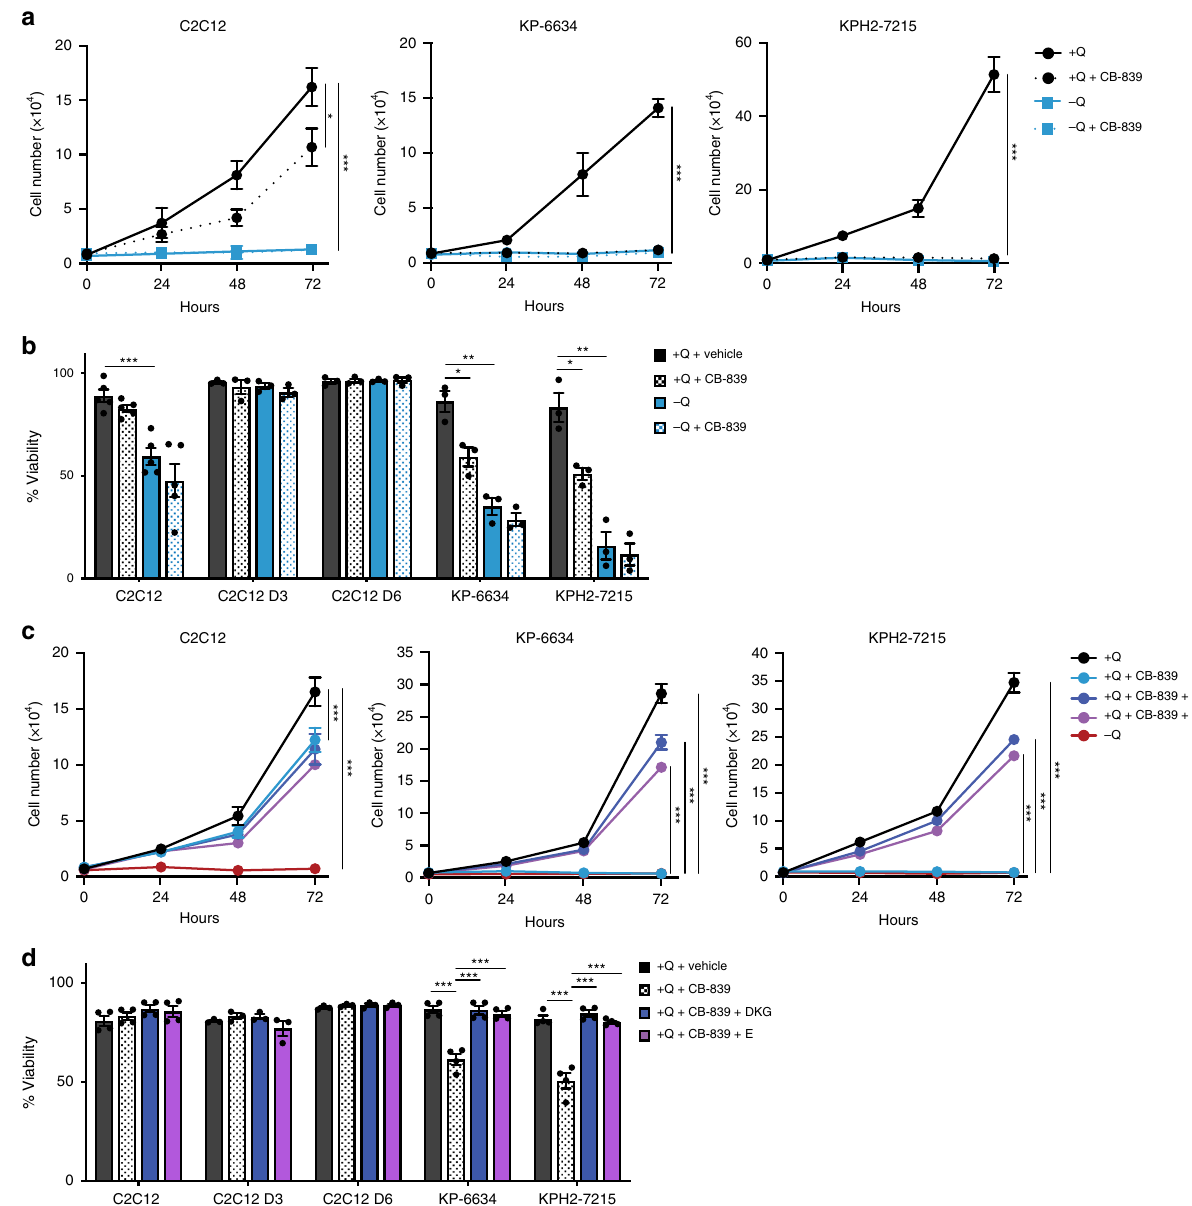
Fig. 5 Glutaminase inhibition with CB-839 and effects on UPS cells. a Proliferation of C2C12s, KP-6634s, and KPH2-7215s (left to right) grown in media with or without glutamine (Q) and treated with 1 μ M CB-839. N = 3 with three technical replicates. Data represent mean ± s.e.m.; * p < 0.05, *** p < 0.0005. b Viability of C2C12, C2C12 D3, C2C12 D6, KP-6634, and KPH2-7215 cells grown in media with or without Q, treated with 1 μ M CB-839 and assessed after 48 h. N = 3 with two technical replicates. Data represent mean ± s.e.m.; * p < 0.05, ** p < 0.005, *** p < 0.0005. c Proliferation of C2C12s, KP-6634s, and KPH2-7215s (left to right) grown in media with or without Q, treated with 1 μ M CB-839, and 5 mM dimethyl 2-oxoglutarate (DKG) or 2 mM glutamate (E). N = 3 with three technical replicates. Data represent mean ± s.e.m.; *** p < 0.0005. d Viability of C2C12, C2C12 D3, C2C12 D6, KP-6634, and KPH2-7215 cells grown in media with or without Q, treated with 1 μ M CB-839, 5 mM DKG, or 2 mM E, and assessed after 48 h. N = 3 with two technical replicates. Data represent mean ± s.e.m.; *** p < 0.0005. p -Values were calculated from a two-tailed Student ’ s t -test for a – d . Source data are provided as a Source Data fi